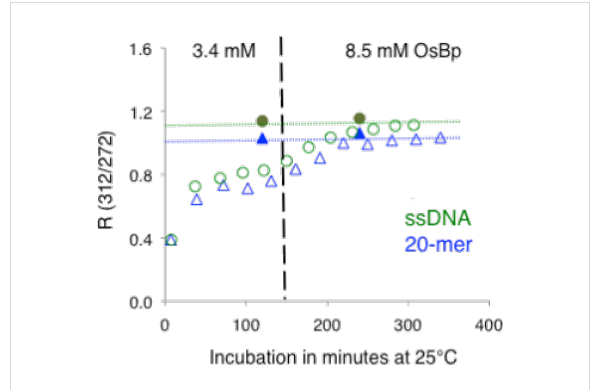
Figure 2: Direct comparison of the kinetics of a 20 nucleotide long deoxyoligo (triangles, PCR primer “16S RNA for”, for simplicity “20-mer”, sequence given in Table 1) and the circular 7249 nucleotide long ssDNA M13mp18 (circles, for simplicity “ssDNA”, see Table 1) as obtained by CE (see Experimental). The data show kinetically comparable reactivity of these two dramatically different materials under three different osmylation conditions, i.e. in 3.4 mM, or in 8.5 mM, or in 13.6 mM OsBp (solid symbols). Dotted lines indicate “theoretical” R 2 for 100% osmylation, as estimated from equation R = 2.01 × (C + T) tot / N tot , obtained earlier using a training set of oligos/ DNA [31]. Theoretical R 2 values at 1.01 and 1.09 and observed R 2 values at 1.05 and 1.18, respectively for “16S RNA for” and ssM13mp18. R 2 values are R (312/272) upon protocol B osmylation that yields practically 100% T + C labeling (see